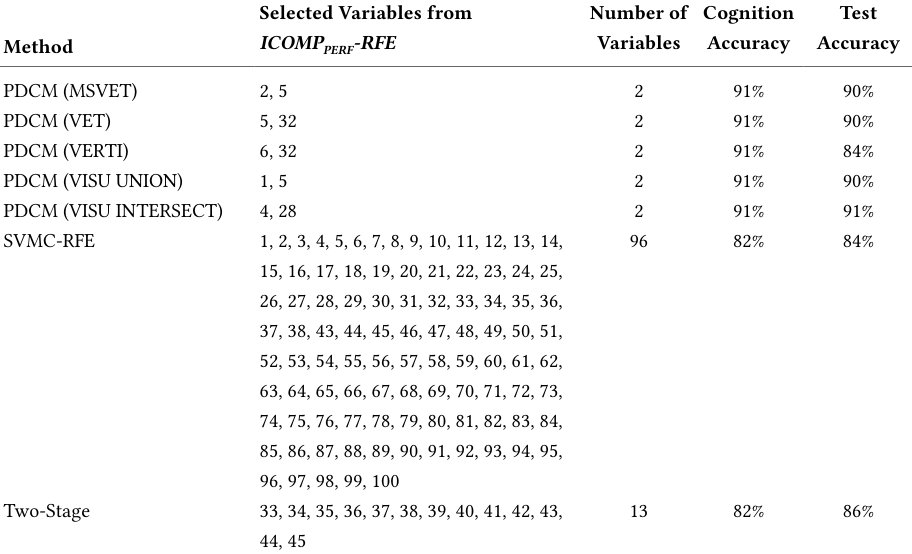
PDCM Versus Various Ranking Based Method Using Cauchy Kernel